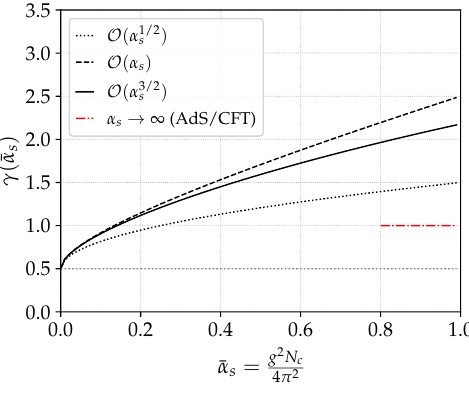
Figure 1. Anomalous exponent of transverse momentum di ff usion as a function of the ’t Hooft coupling for several truncations of the perturbative series. The red curve is the strong coupling